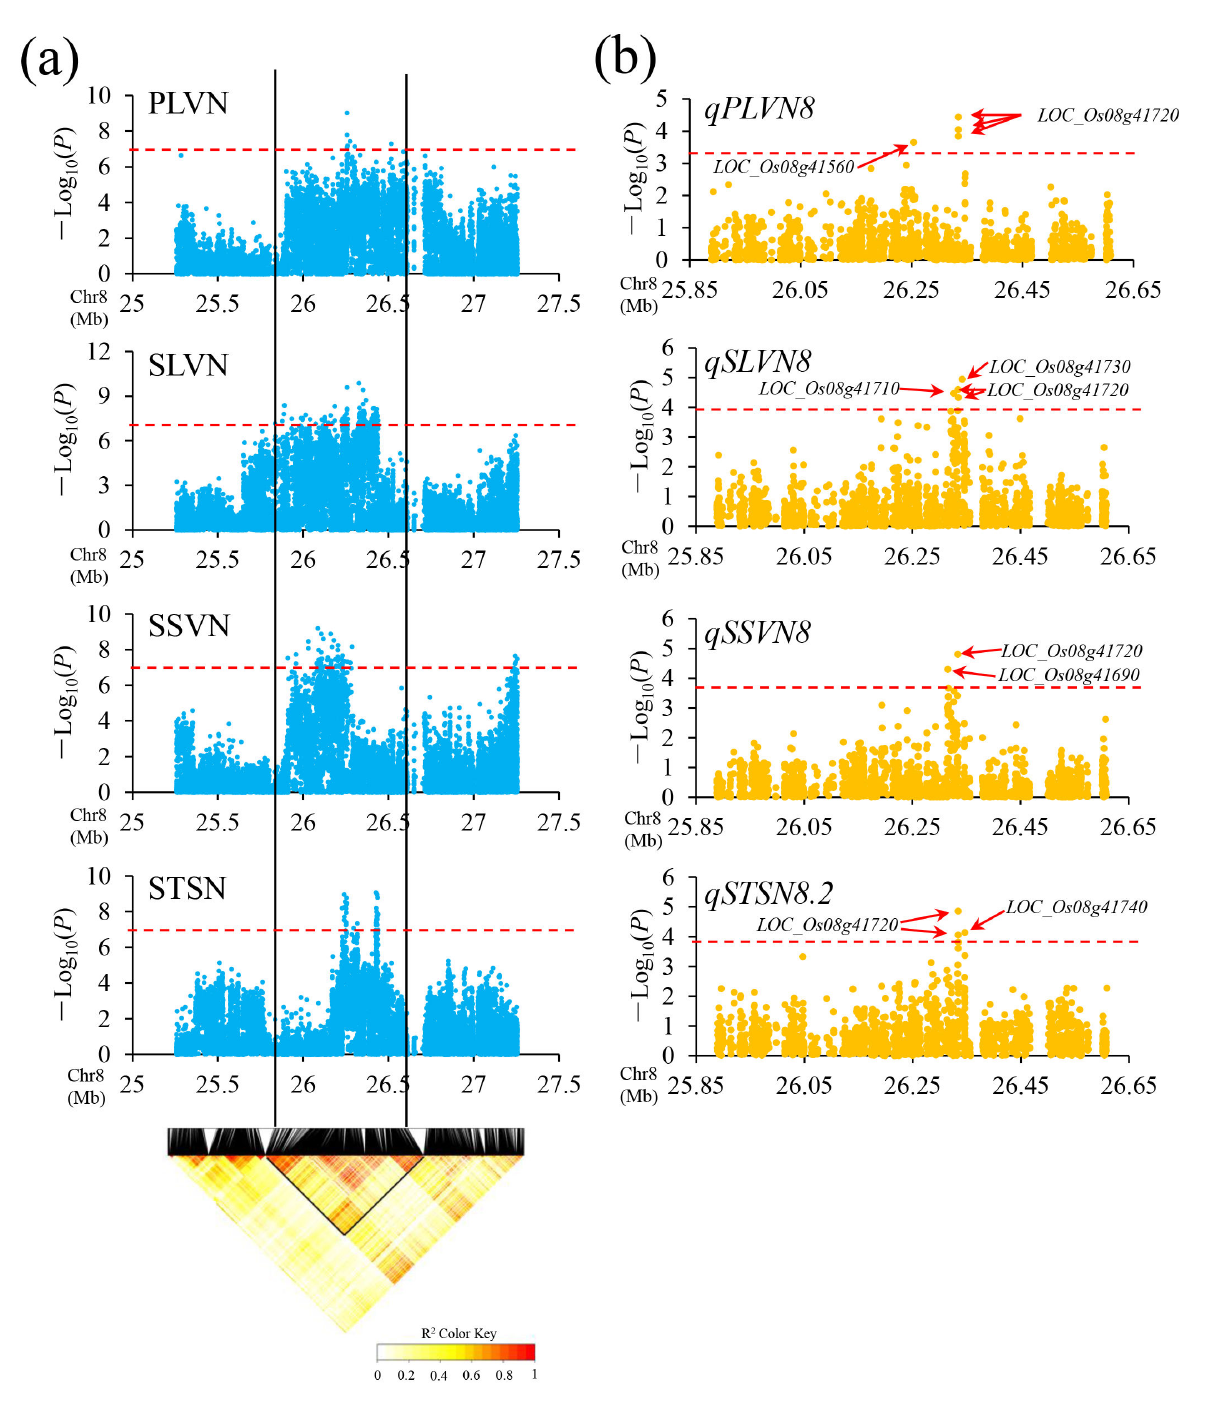
Figure 7. LD block and gene-based association analysis of the QTL cluster associated with qPLVN8 , qSLVN8 , qSSVN8, and qSTSN8.2 on chromosome 8. ( a ) Local Manhattan plot (top) and LD block (bottom) surrounding the peak on chromosome 8. Black lines indicate the candidate region for the peak. ( b ) Gene-based association analysis of targeted genes within the LD block. Dash lines show the threshold to determine significant